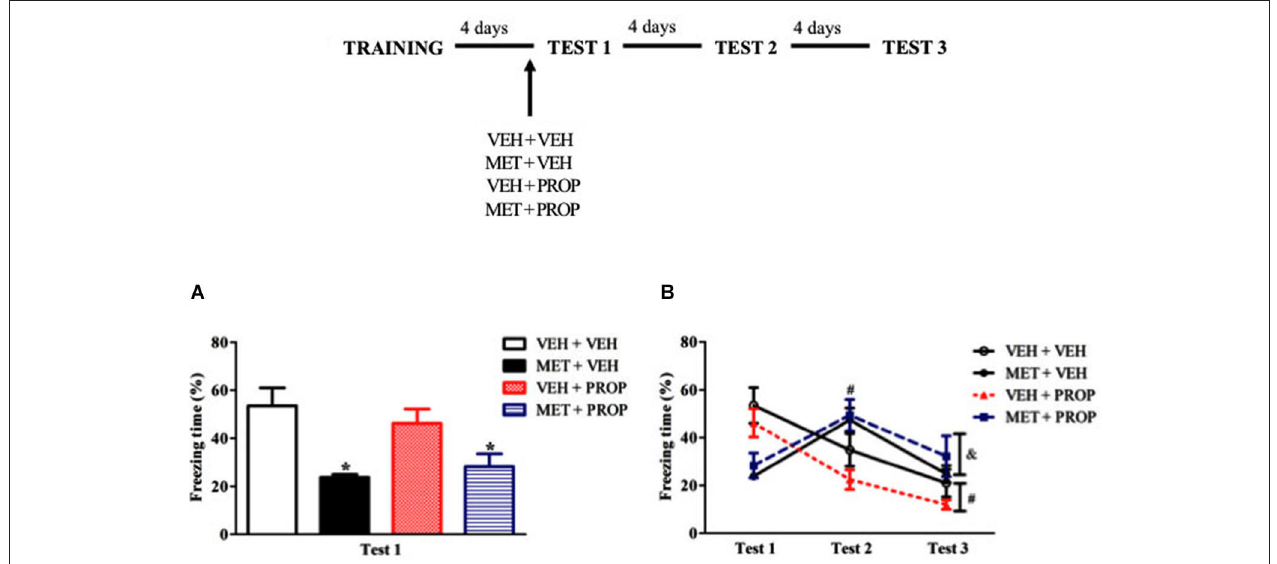
VEH + VEH = vehicle group ( n = 10); MET + VEH = metyrapone group ( n = 8); VEH + PROP = propranolol group ( n = 9); MET + PROP = metyrapone and propranolol group ( n = 9). * P < 0.05, compared to control group; # P < 0.05, compared to Test 1, for all groups on Test 2 and for VEH + VEH and VEH + PROP on Test 3; & P < 0.05, compared to Test 2, for MET-treated groups.